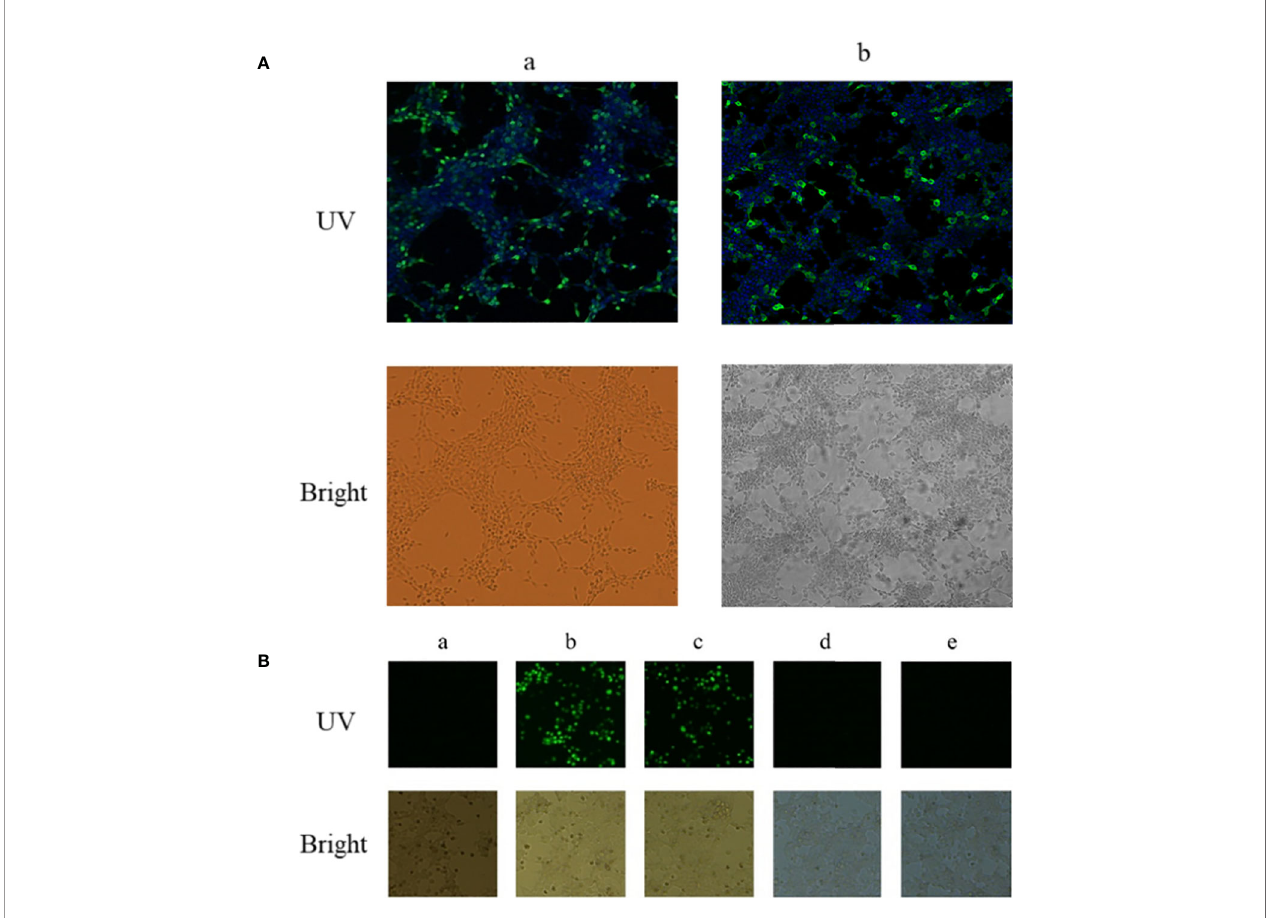
FIGURE 3 | Interaction between Et CDPK4 and Et eIF-5A by bimolecular fl uorescence complementation. (A) 293T cells were transfected with pBiFC-VN155- Et eIF-5A or pBiFC-VC155- Et CDPK4 and analyzed with IFA using antisera r Et eIF-5A and antisera r Et CDPK4: (a) pBiFC-VN155- Et eIF-5A transfected into 293T cells; (b) pBiFC- VC155- Et CDPK4 transfected into 293T cells. In UV fi gures, pBiFC-VN155- Et eIF-5A or pBiFC-VC155- Et CDPK4 showed with green fl uorescence, the nucleus stained to blue fl uorescence. (B) Interaction between Et CDPK4 and Et eIF-5A by bimolecular fl uorescence complementation. a, negative control; b, positive control; c, pBiFC- VC155- Et CDPK4 and pBiFC-VN155- Et eIF-5A co-transfected into 293T cells; d, pBiFC-VC155- Et CDPK4 and pBiFC-VN155 co-transfected into 293T cells; e, pBiFC- VN155- Et eIF-5A and pBiFC-VC155 co-transfected into 293T